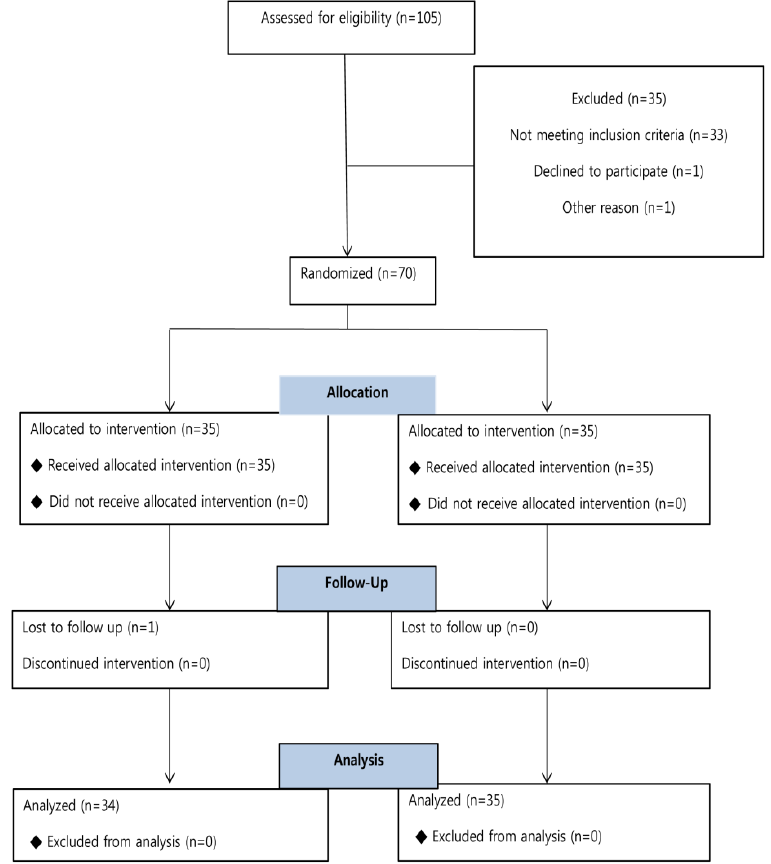
Figure 1. Research flow chart.